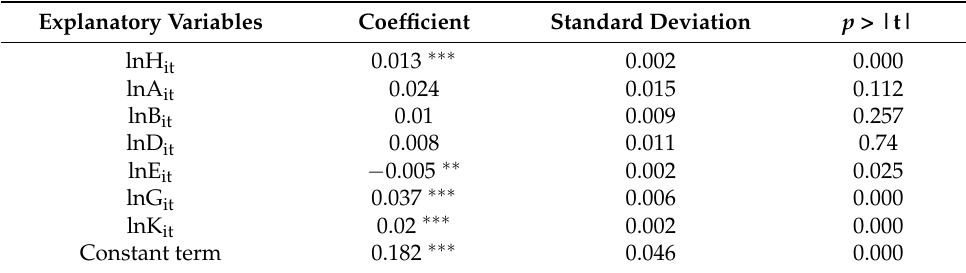
Table 3. Descriptive statistics of the